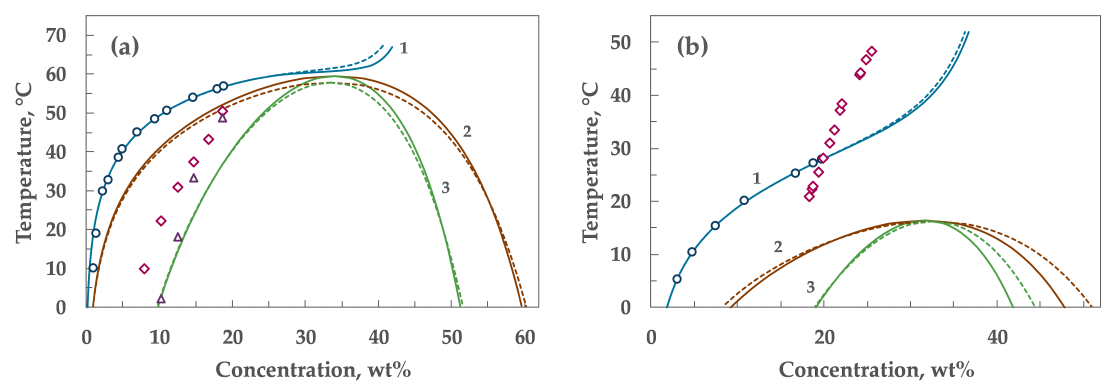
Figure 4. Experimental data and model predictions for ( a ) C 35 H 41 Cl 2 N 3 O 2 (form I) – ethanol / water system [48] and ( b ) for vanillin in 1-propanol / water [52]. In both ( a ) and ( b ), the open circles and diamonds indicate the experimental data points for solubility and oiling out (binodal), respectively. In ( a ), the triangles are the spinodal points reported in [48] obtained through extrapolation of the light scattering intensity data [50]. Curve 1 represents the model ( µ l = µ s ) fit to solubility data using Equations (16) and (17). The square-well interaction parameters (listed in Table 4) obtained from these fits were used to further calculate the binodal (curve 2) and spinodal (curve 3) boundaries. The dotted lines are the curves obtained using Equation (11) and the solid lines are those obtained with Equation (12), respectively, for calculating η e ff